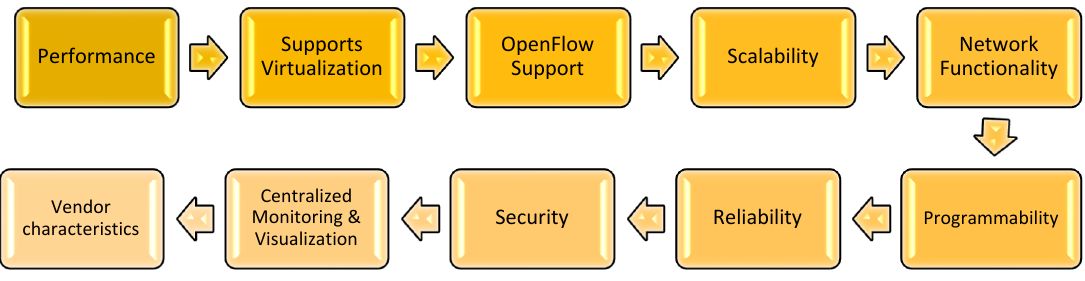
Figure 32. SDN controller functionality: 10 key factors.